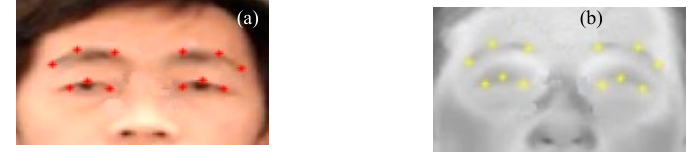
Figure 9. Landmarks as control points for registration accuracy evaluation: ( a ) visible image; ( b ) IR image. Table 2. Registration Matching Error (Landmarks around the eye region as control points), pixels.